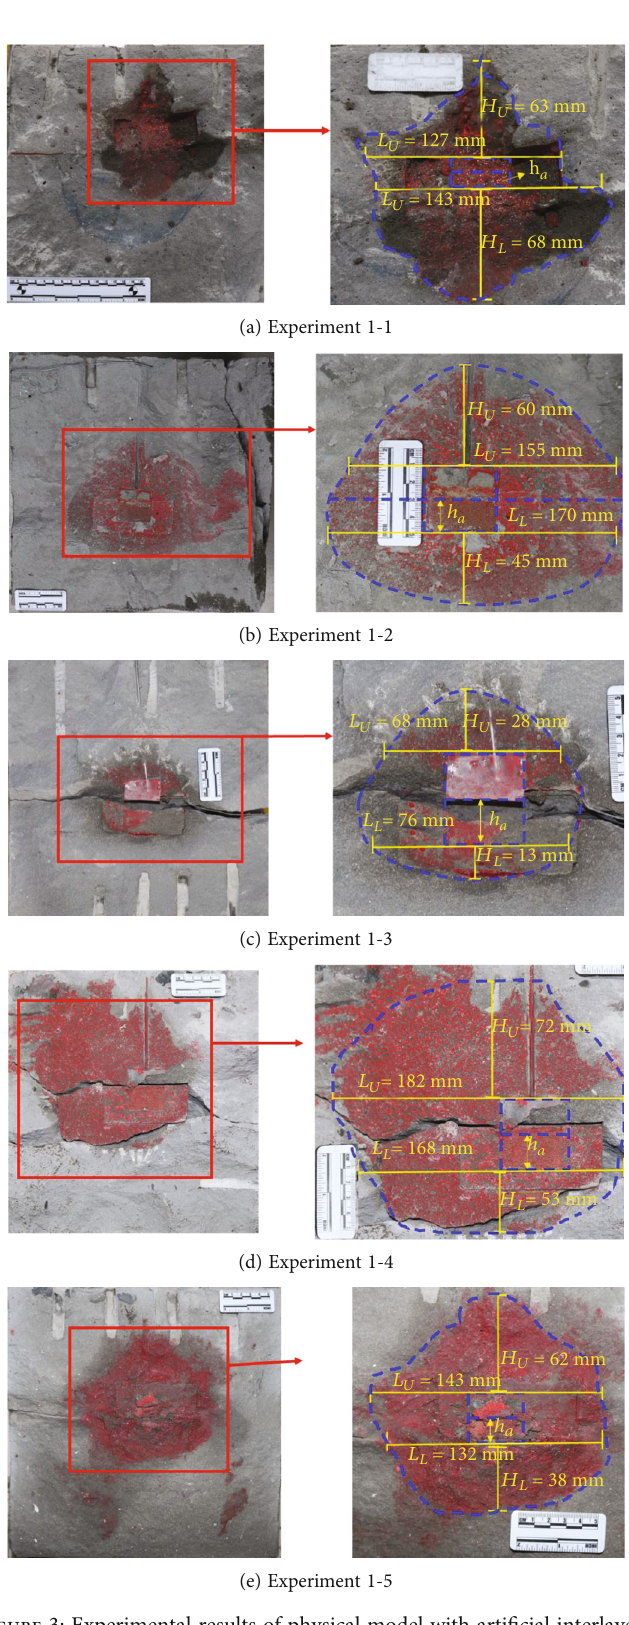
Figure 3: Experimental results of physical model with arti fi cial